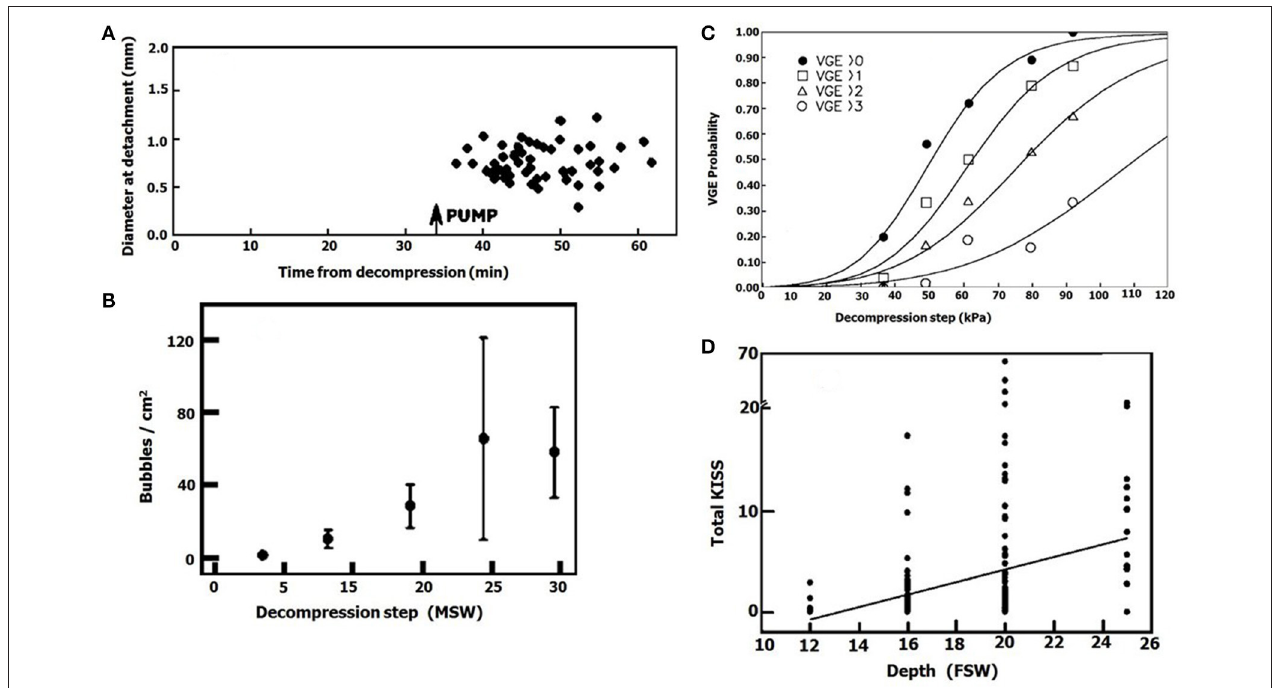
FIGURE 13 | Effect of exposure pressure on bubble formation. (A) Diameter of bubbles which detached from an ovine blood vessel plotted against time from decompression. The first period before pump operation (gas tension in the proximity of the vessel 228 kPa), and the second after pump operation (gas tension in the proximity of the vessel 600 kPa). (B) Density of decompression bubbles on a hydrophobic silicon wafer as a function of exposure pressure (taken from Arieli and Marmur, 2013a with permission). (C) Bubble score in a diver after decompression from various pressures (adapted from Eckenhoff et al., 1990 with permission). (D) Bubble score after decompression from various depths (adapted from Cameron et al., 2007 with